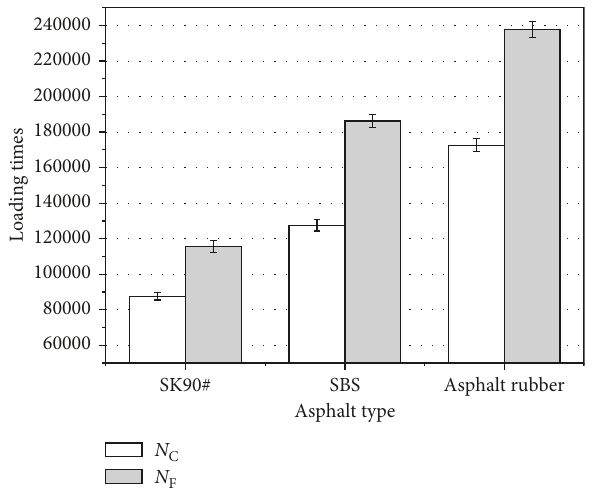
Figure 8: The influence of asphalt type on fatigue cracking life and fatigue fracture